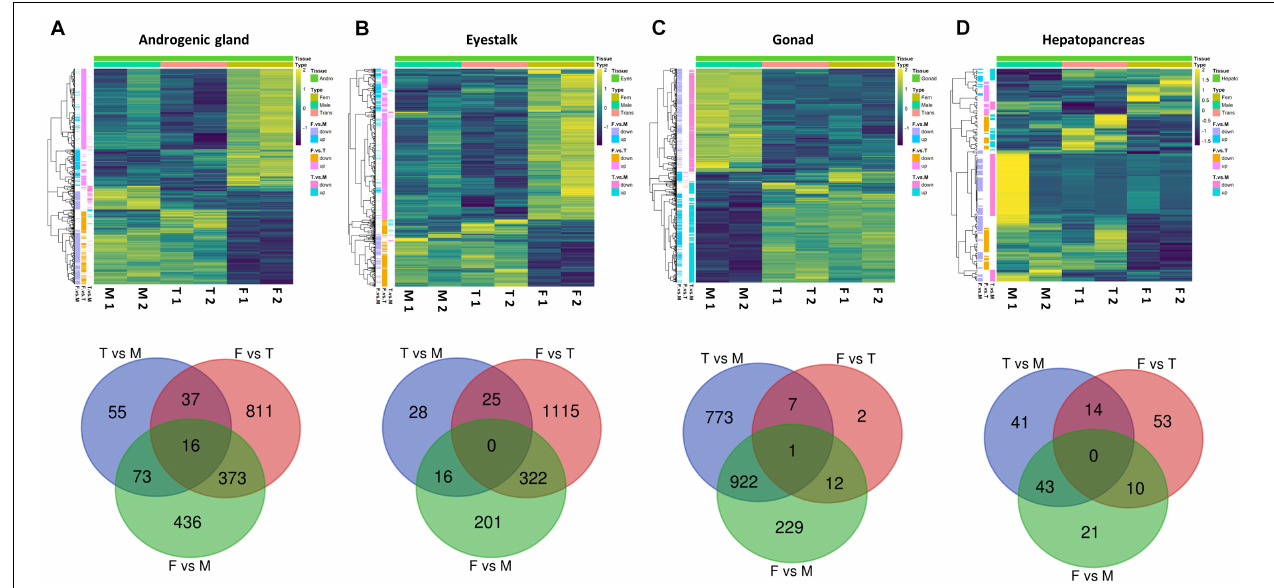
FIGURE 5 | Differentially expressed genes at different reproductive stages of P. platyceros . Significant differential genes (FDR adjusted P -value < 0.05 and absolute linear fold change > 1.3) between males (M), transitionals (T), and females (F) in the following tissues (A) androgenic gland, (B) eyestalk, (C) gonad and (D) hepatopancreas are given. (Top) Heatmaps represent the intensity of variation in gene expression between different reproductive stages (two pooled samples in each stage). (Bottom) Venn diagrams represent the number of genes that were found to be significantly different when comparing expression patterns from the different reproductive stages in each tissue. A list of all significant differential genes between males and females in the different tissues are given in Excel table in the Supplementary Material